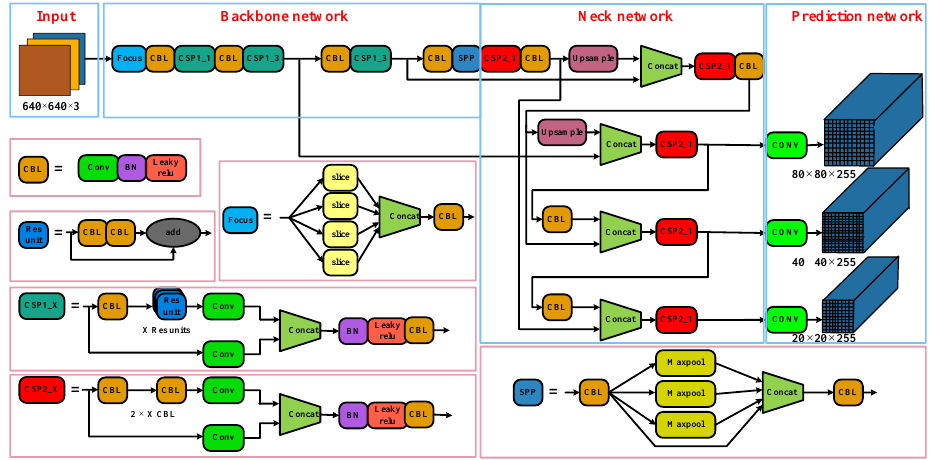
Figure 1. The basic framework of YOLOv5, consisting of four modules: The input module, backbone network, neck network, and prediction